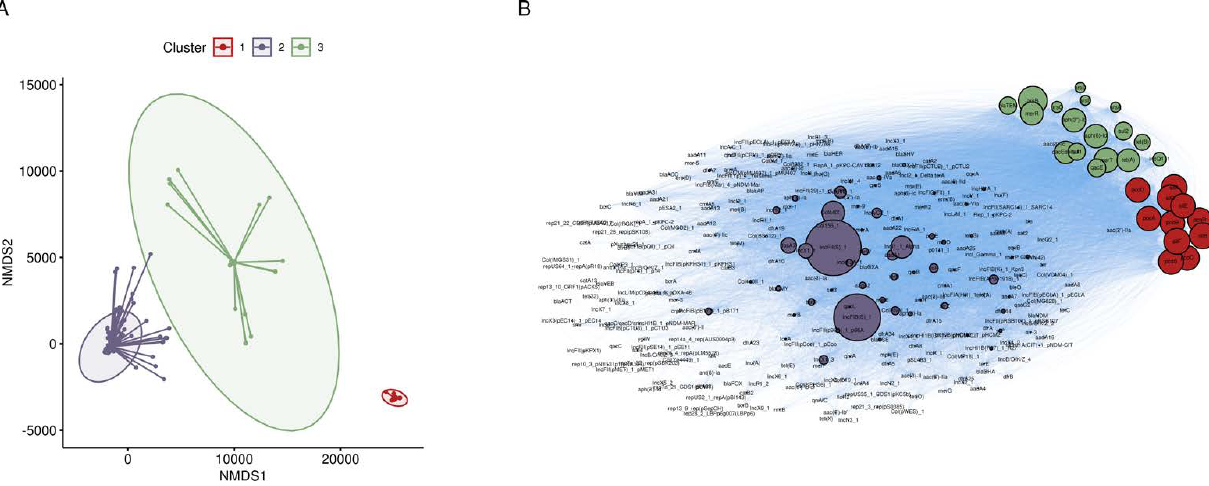
Figure 2. Co-occurrent gene clusters identified in S. enterica genomes. ( A ) Non-metric Multi-dimensional Scaling plot of a co-occurrence matrix generated from plasmid replicons, antibiotic and metal resistance homologues. K-means clustering was used to group genes. An elbow plot was used to pick the optimal number of clusters. Clusters are drawn as a star plot with lines connecting each gene to the centroid. Gaussian distributions were drawn around each cluster. ( B ) Network representation of co-occurrence network. Nodes are scaled to edge weight (number of connections) and are colored consistent to